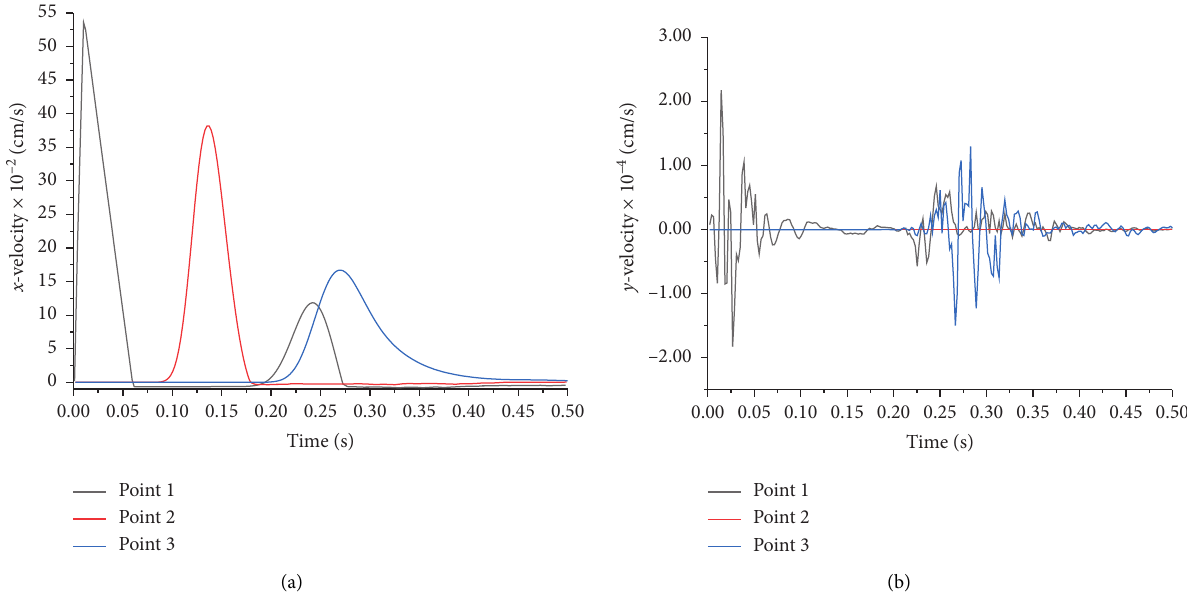
Figure 12: Speed-time curve of measuring point. (a) x -velocity. (b) y